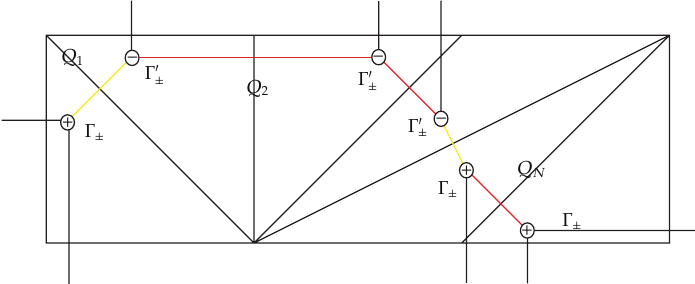
Figure 8: Toric Calabi-Yau manifolds represented by a triangulation of a strip. There are N independent P 1 ’s with K¨ahler parameters Q (cid:7) e − T i , and N (cid:9) 1 vertices to which we associate Γ and Γ (cid:3) operators i represented respectively by ⊕ and (cid:14) signs. Yellow intervals, which connect vertices with opposite signs, represent O (cid:4) − 1 (cid:5) ⊕ O (cid:4) − 1 (cid:5) → P 1 local neighborhoods. Red intervals, which connect vertices with the same signs, represent O (cid:4) − 2 (cid:5) ⊕ O → P 1 local neighborhoods. The first vertex on the left is chosen to be ⊕